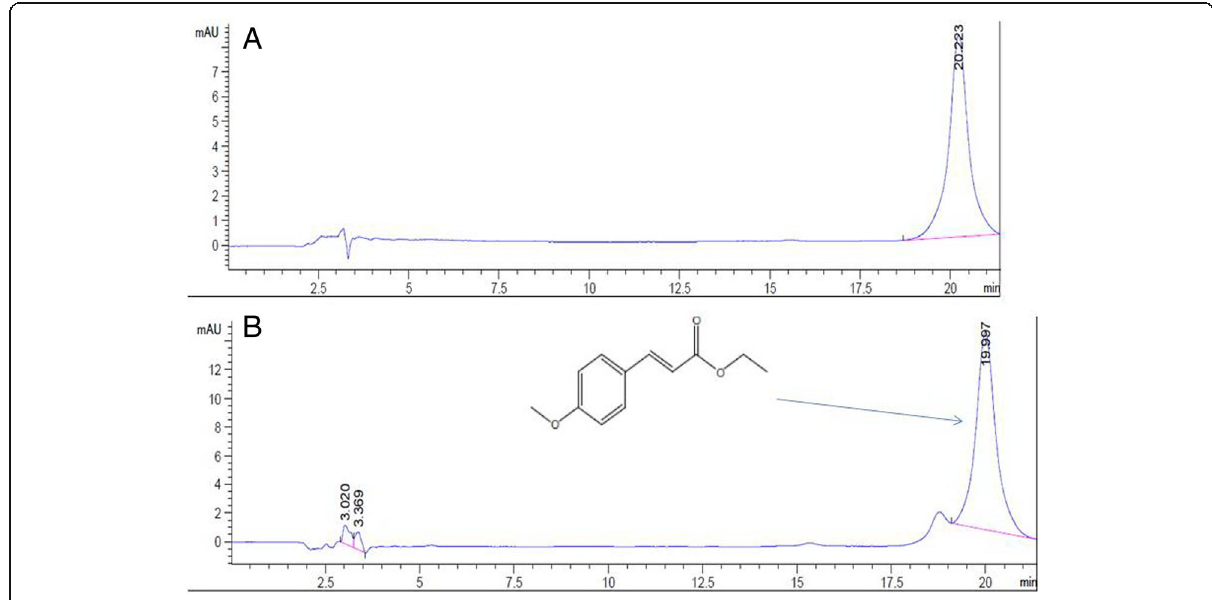
Fig. 1 HPLC chromatograms of a standard ethyl- p -methoxycinnamate (EPMC) and b K. galangal Linn.rhizome extract. Chromatographic separation condition used was as follows: Thermoscientific ™ Hypersil Gold Column 5 μ m C18 column; mobile phase consisting of a mixture of water and methanol with isocratic elution (46%: 54% v /v) at follow rate of 1 ml/min; injection volume of 10 μ l; and UV-detection at 270